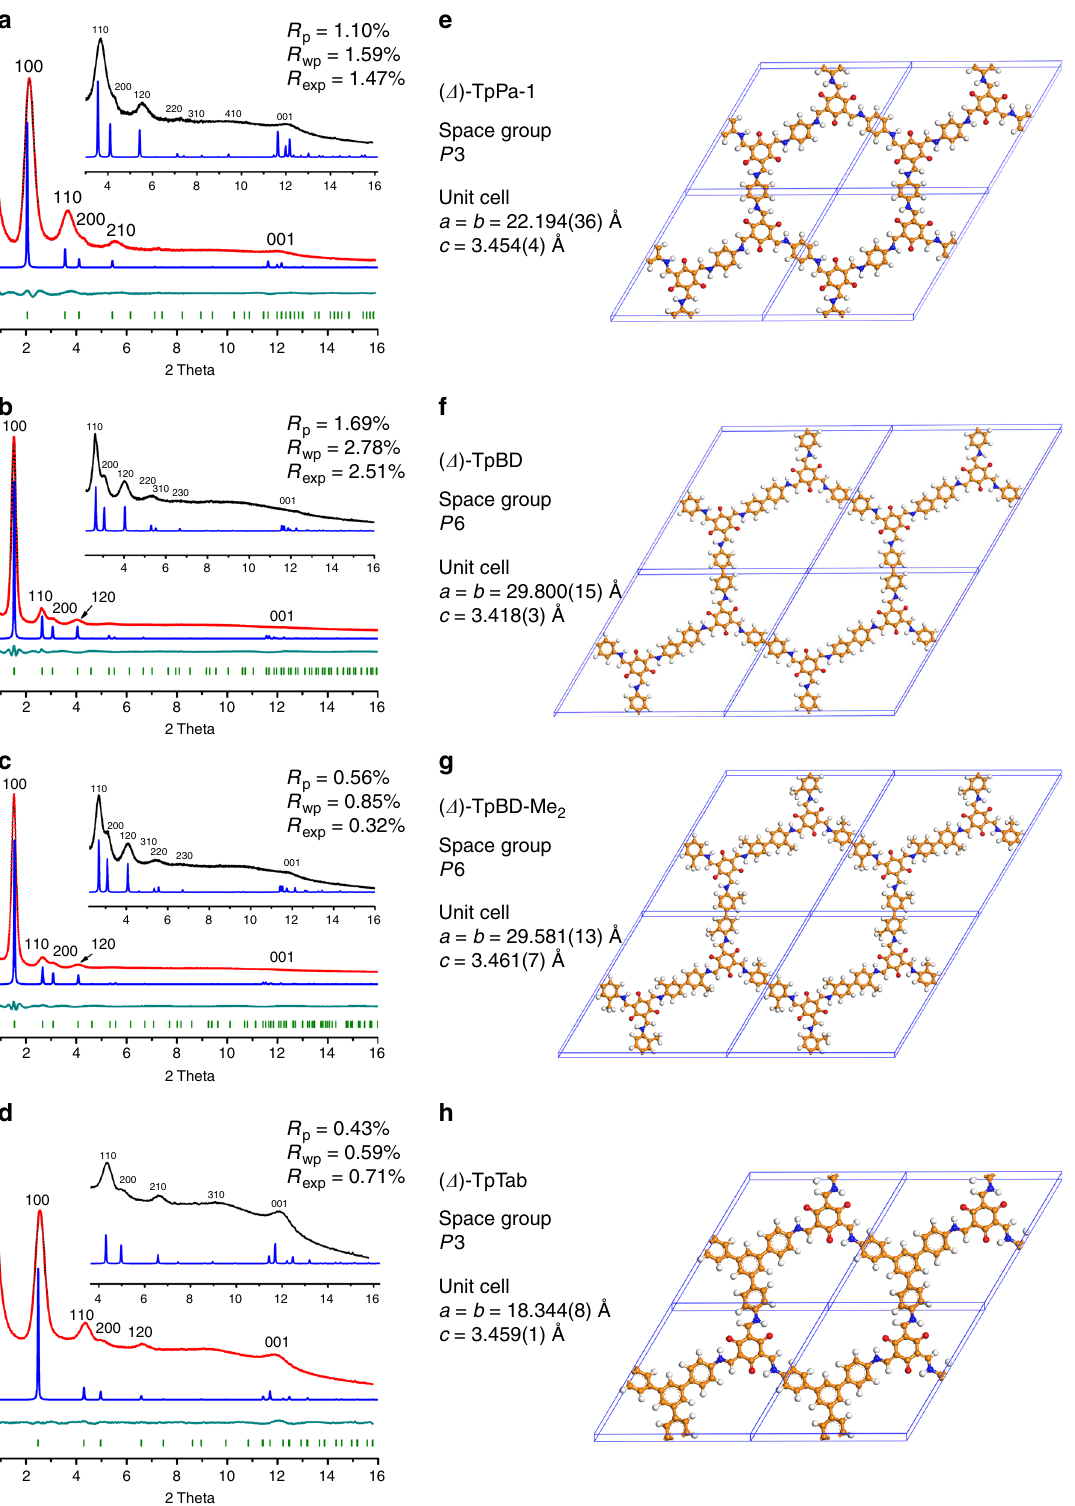
Fig. 4 Synchrotron PXRD patterns and the corresponding Rietveld re fi ned structures. a – d Experimental synchrotron PXRD data (black lines), simulated pattern (blue lines), and Rietveld re fi nements (red lines) of the CCOFs. Simultaneous Rietveld re fi nements of the high-resolution (red lines) provide good fi ts to the experimental data with only minimal differences (the dark cyan lines show the difference plots between the experimental PXRD patterns and those obtained by Rietveld re fi nements); Bragg positions are indicated by light green ticks. λ = 0.689 Å for the high-resolution data. TpPa-1 ( a ), TpBD ( b ), TpBD-Me 2 ( c ), and TpTab ( d ). e – h The corresponding Rietveld re fi ned structures of the TpPa-1 ( e ), TpBD ( f ), TpBD-Me 2 ( g ), and TpTab ( h